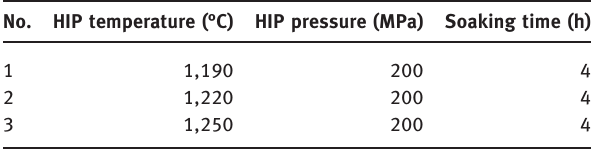
Table 1: HIP schedules applied to the damaged